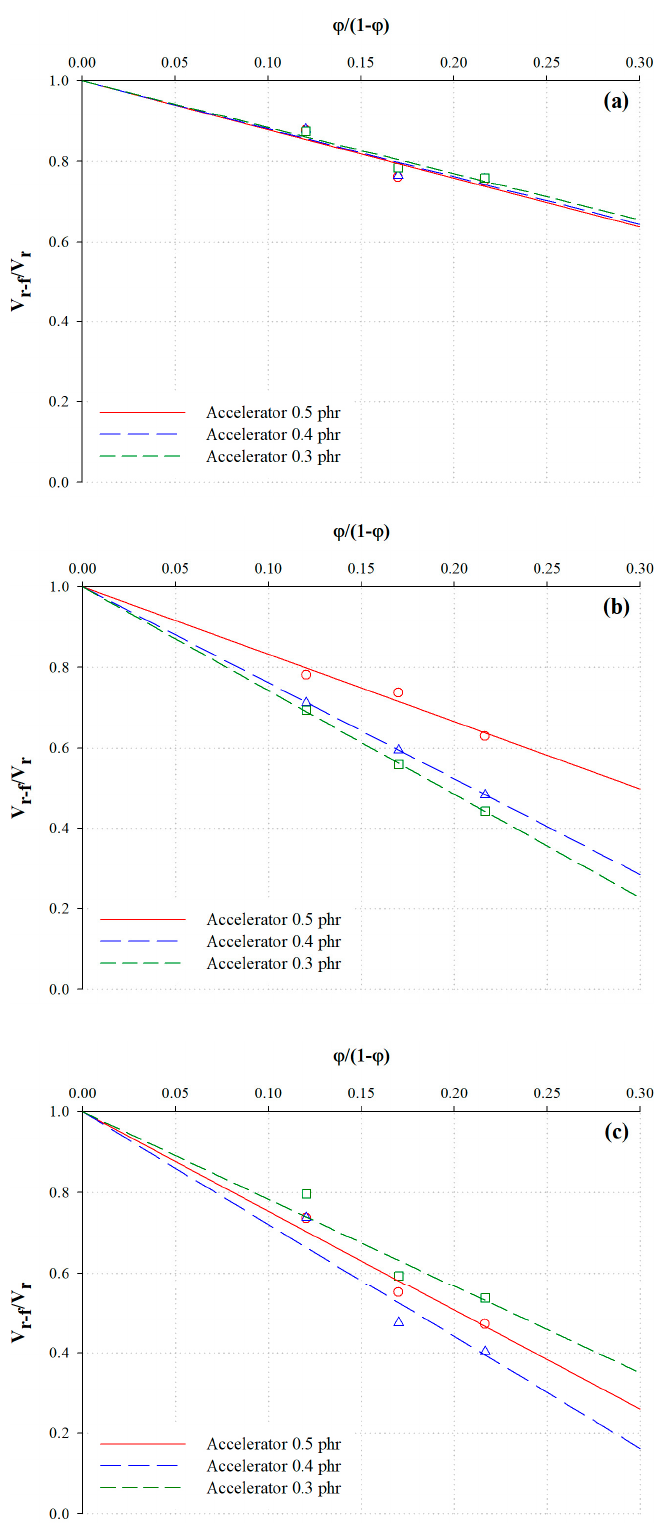
Figure 2. Kraus plot of NR with varying carbon black content ( a ) before sulfide cleavage, ( b ) after polysulfide cleavage, and ( c ) after cleavage of both disulfide and polysulfide.